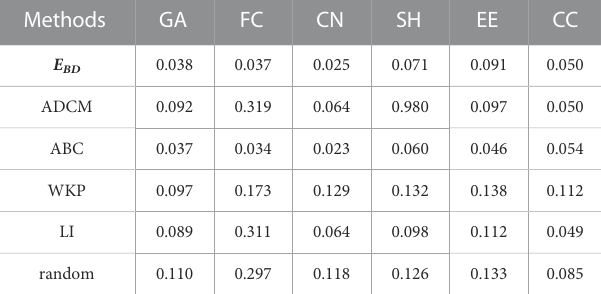
TABLE 2 Average I prop in different networks. The obtained numbers represent the average value of ordinates of points on the same line in Figure 6.